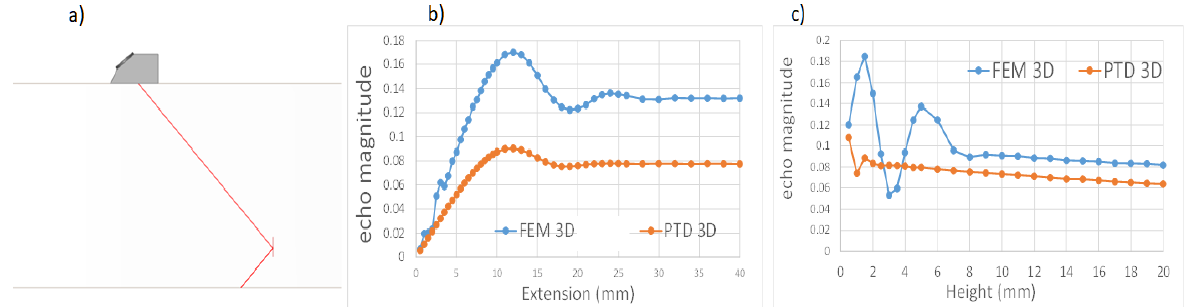
Figure 8. ( a ) Inspection of rectangular crack using SV45 waves in Pulse Echo mode at 2.25 MHz (circular planar probe of 6.35 mm diameter), ( b ) of 5 mm height and varying extension and ( c ) of a 34 mm extension and varying height.